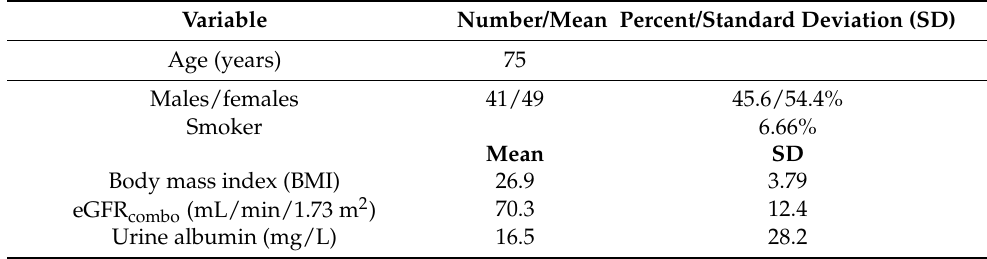
Table 1. Basic characteristics of the population (n = 90). eGFR = estimated glomerular filtration rate.